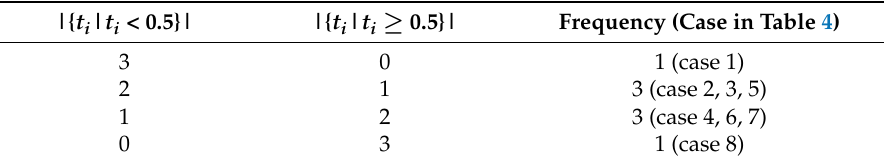
Table 5. Unique cases for the half-split of [0,